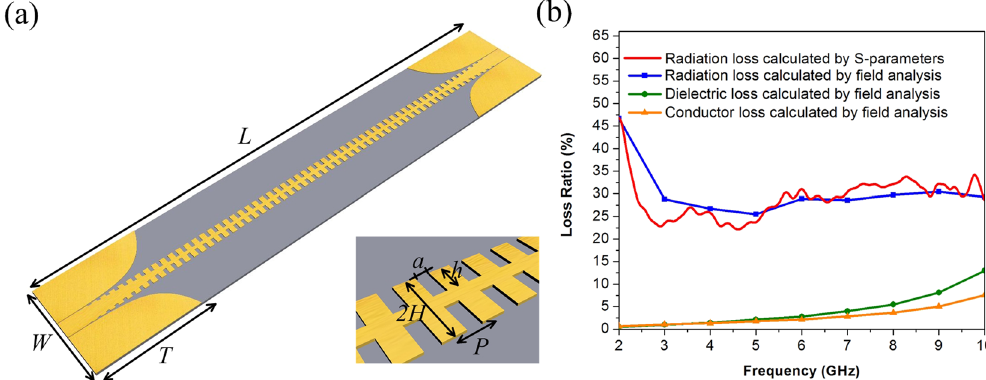
Figure 1. ( a ) The configuration of the SPP TL under study in which L = 325 mm, W = 60.8 mm, T = 60 mm, thickness of the F4B substrate is 0.5 mm and thickness of the copper conductor is 0.035 mm. The geometry of the unit cell in which P = 5 mm, a = 2 mm, h = 4 mm, H = 5 mm. ( b ) Simulated energy losses from different